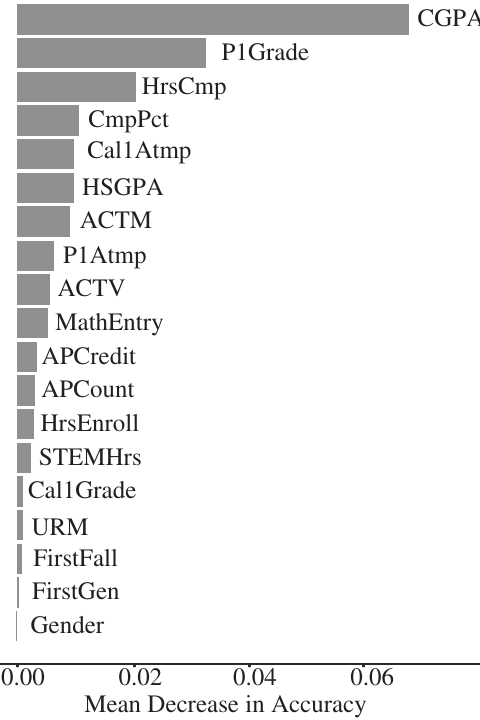
FIG. 4. Physics 2 variable importance for the institutional